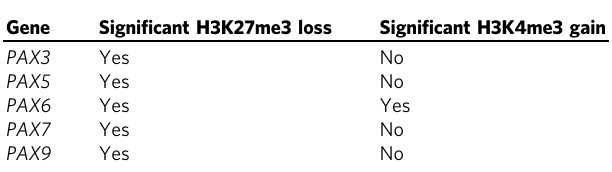
Table 1 Derepression of PAX gene family members upon OTX2